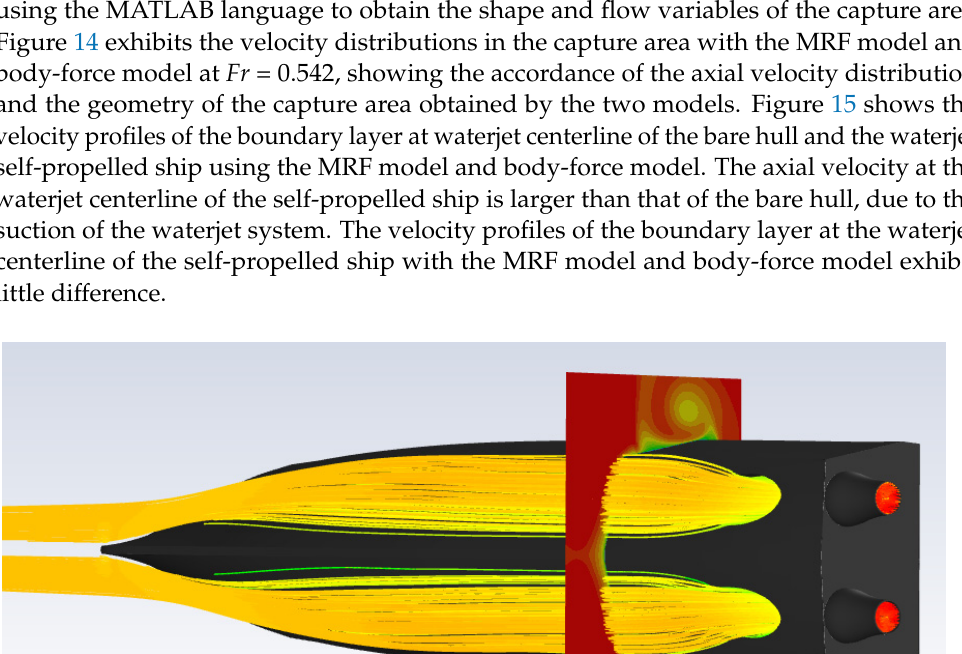
Figure 14. Velocity distributions in the capture area with the MRF model and body-force model (BFM). Figure 15. Velocity profiles of boundary layer at waterjet centerline of the bare hull (BH), MRF model and body-force model (BFM). ζ is the vertical distance from ship bottom plating. Table 5. Calculation (cid:4666)1 − 𝑤 ) and 𝐶 (cid:3040) of the capture area with the MRF model and body-force model. Fr MRF (cid:4666)𝟏 − 𝒘 𝑴 (cid:4667)